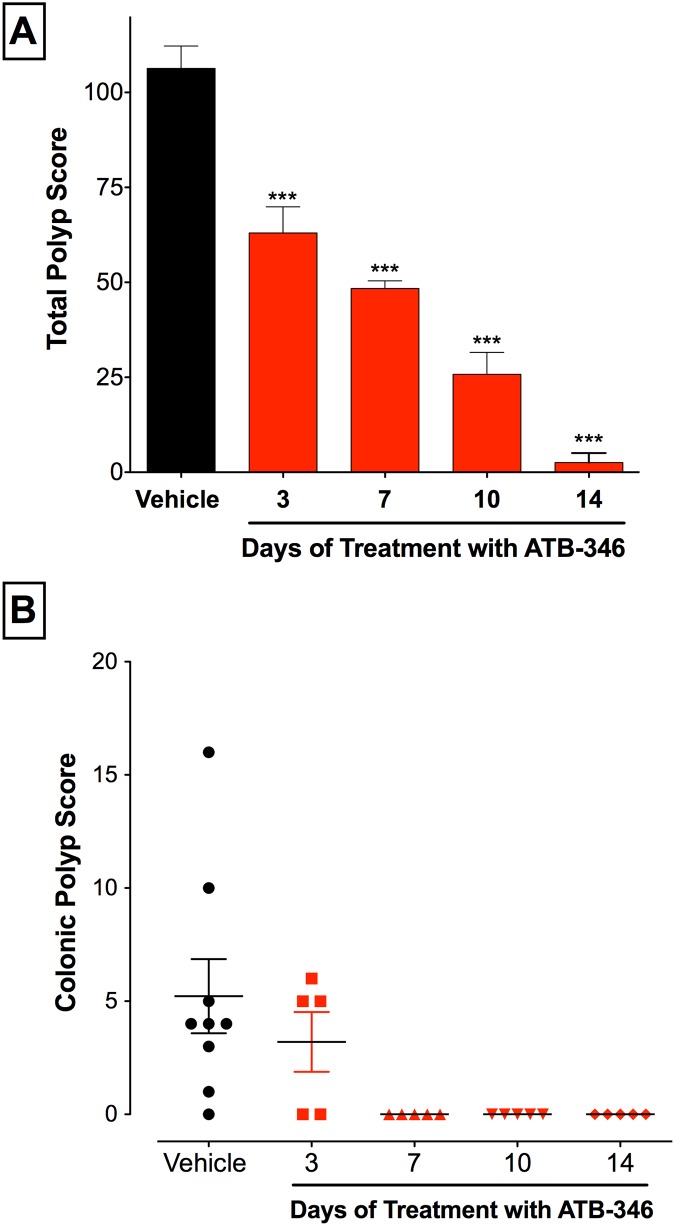
Duration-of-treatment-dependent reduction of total polyp score by ATB-346.Panel A: APCMin/+ mice treated with ATB-346 at 14.5 mg/kg (equimolar to 10 mg/kg of naproxen) for up to 14 days, starting at week 6 of life, had significantly lower total polyp scores as compared to vehicle-treated mice (***p<0.001 compared to the vehicle-treated group). Data are expressed as mean ± SEM (n≥5 per group). Panel B: ApcMin/+ mice treated once daily with ATB-346 for up to 14 days had significantly lower colonic polyp scores compared to vehicle. In the 7-, 10- and 14-day treatment groups, there was a complete absence of polyps (p<0.05; Mann-Whitney test; n≥5 per group). The bars on the figure represent the mean ± SEM.